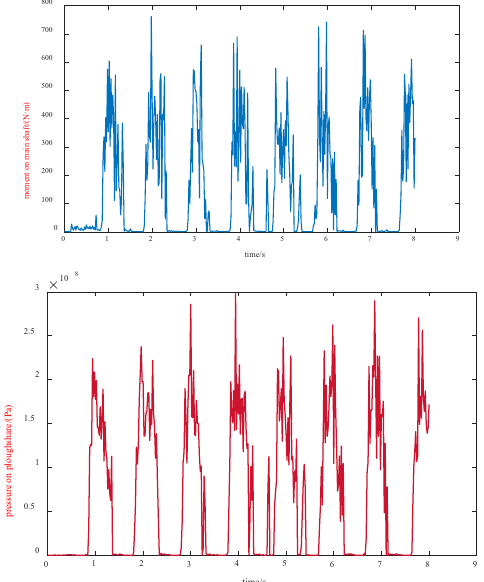
Fig. 10. Curve of resistance moment and pressure of Exp.